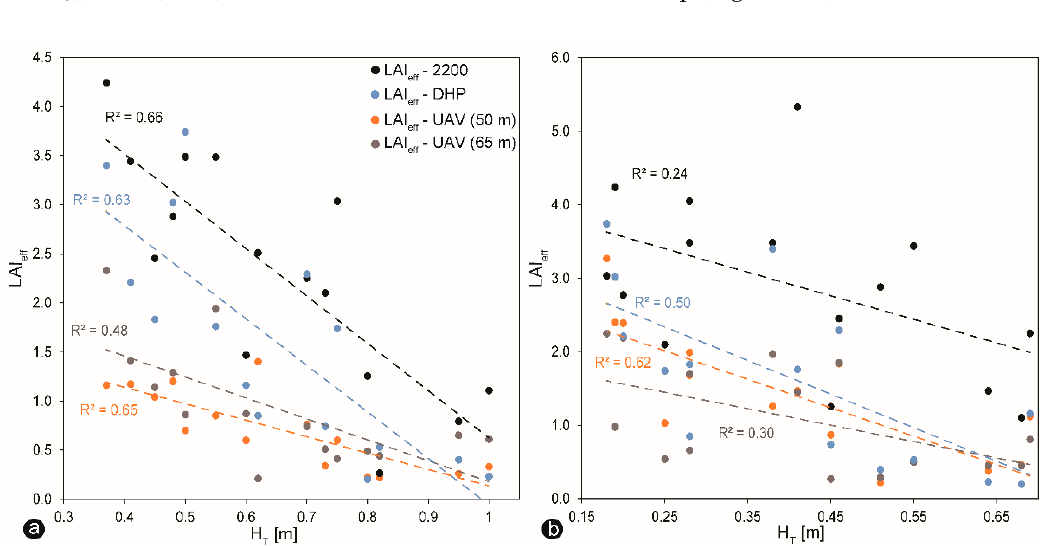
Figure 11. The plotted relation between effective LAI (LAI eff ) estimates and manual snow depth samplings (H T ) during snow accumulation ( a ) and during snow ablation ( b ) at the zone of overlapping ground-based measurements. Dashed lines represent linear regressions.